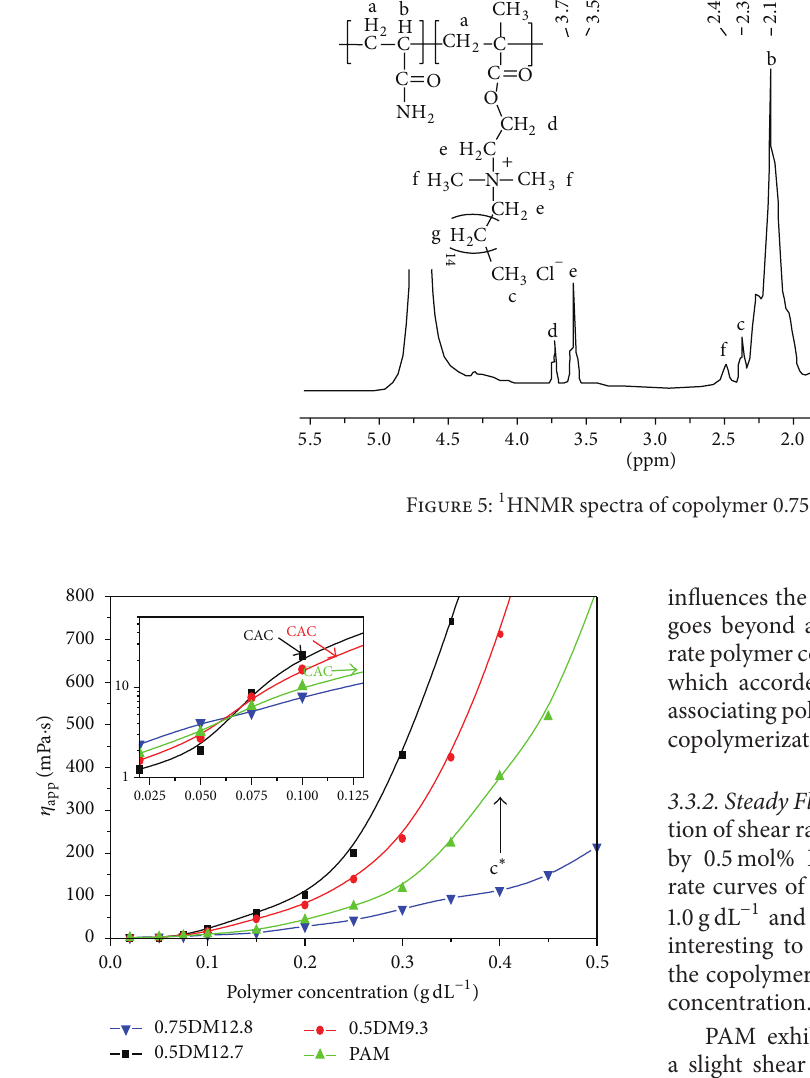
Figure 6: Apparent viscosity as a function of polymer concentration for copolymers 0.75DM12.8, 0.5DM12.7, and 0.5DM9.3 samples and for a PAM sample ( 𝑇 = 25 ∘ C, the inlet of apparent viscosity is partially enlarged for purpose of smart